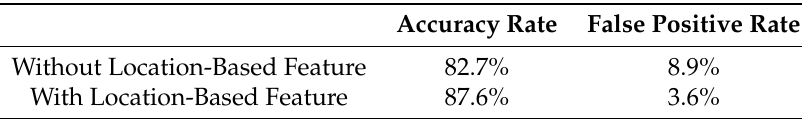
Table 4. Evaluation of location-based features’